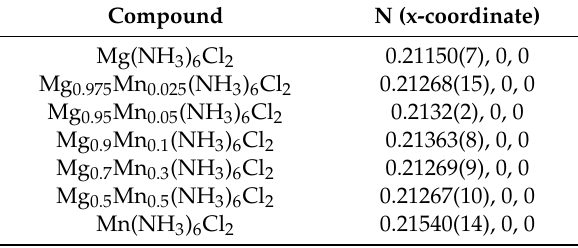
Table 1. Atomic positions of the monometallic and mixed hexammines: Mg 1 − x Mn x (x = 0 to 1) in (0, 0, 0), Cl in (1/4, 1/4, 1/4) and N in (x, 0, 0) *.